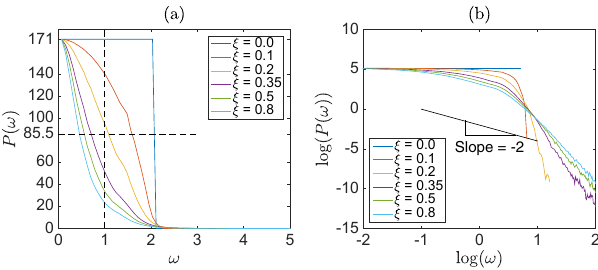
Figure 11. Participation ratio or localization length with respect to different frequencies for 500 ensembles with ξ = 0 . 1 , 0 . 2 , 0 . 35 , 0 . 5 and 0 . 8 and bin size = 0.0781.